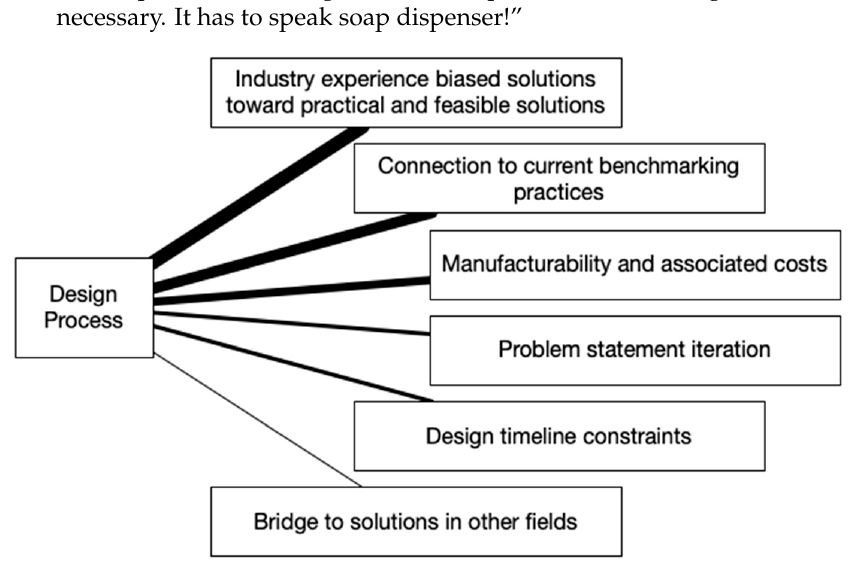
Figure 9. Design process discussion themes.